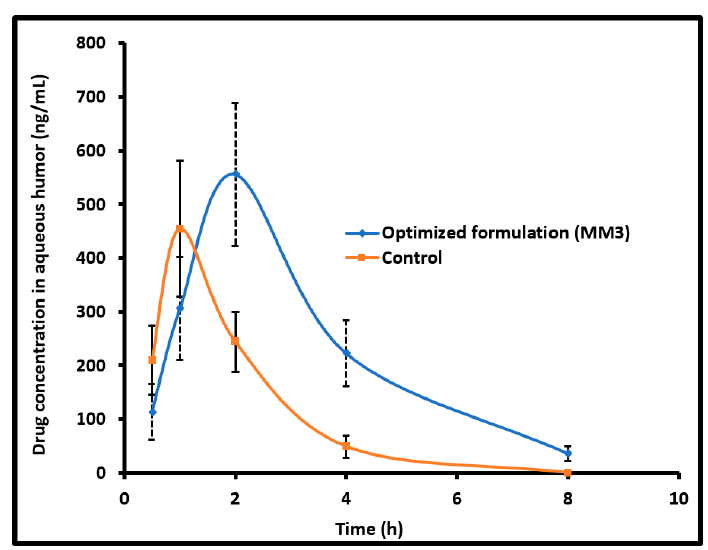
Figure 6. Comparison of mean moxifloxacin concentration in the aqueous humor following topical installation of optimized nanoemulsion (MM3) and control (commercial eye drops) in rabbits. The data represents average ± SD of six trials.